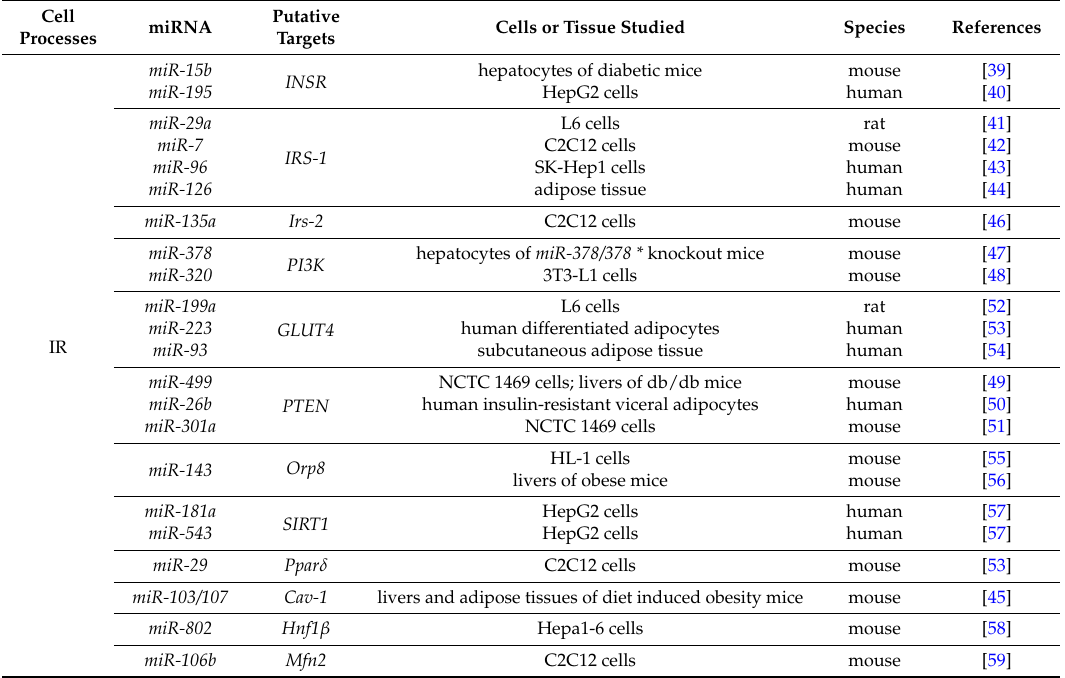
Table 2. Principle miRNAs involved in insulin resistance